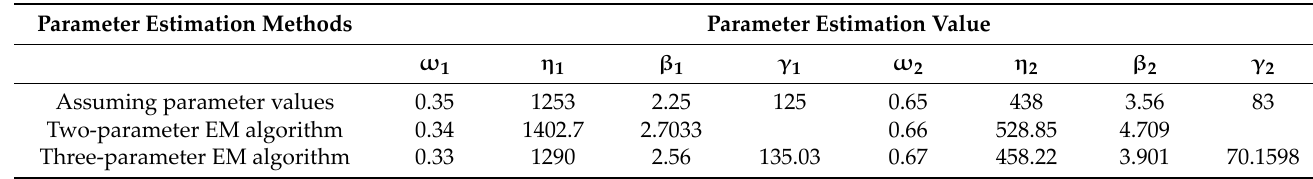
Figure 4. Simulation of fitted probability density functions of failure times.